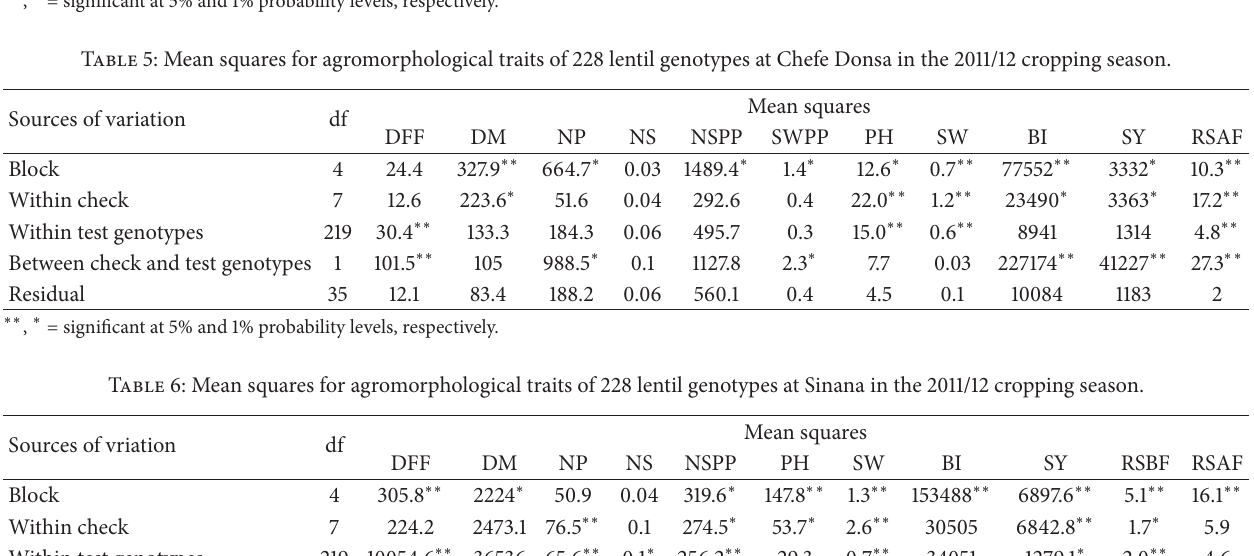
Table 4: Mean squares for agromorphological traits of 228 lentil genotypes at Sirinka in the 2011/12 cropping season. Sources of Variation df Block Within checks Within test genotypes 219 Between check and test genotypes 1 0.6 Residual